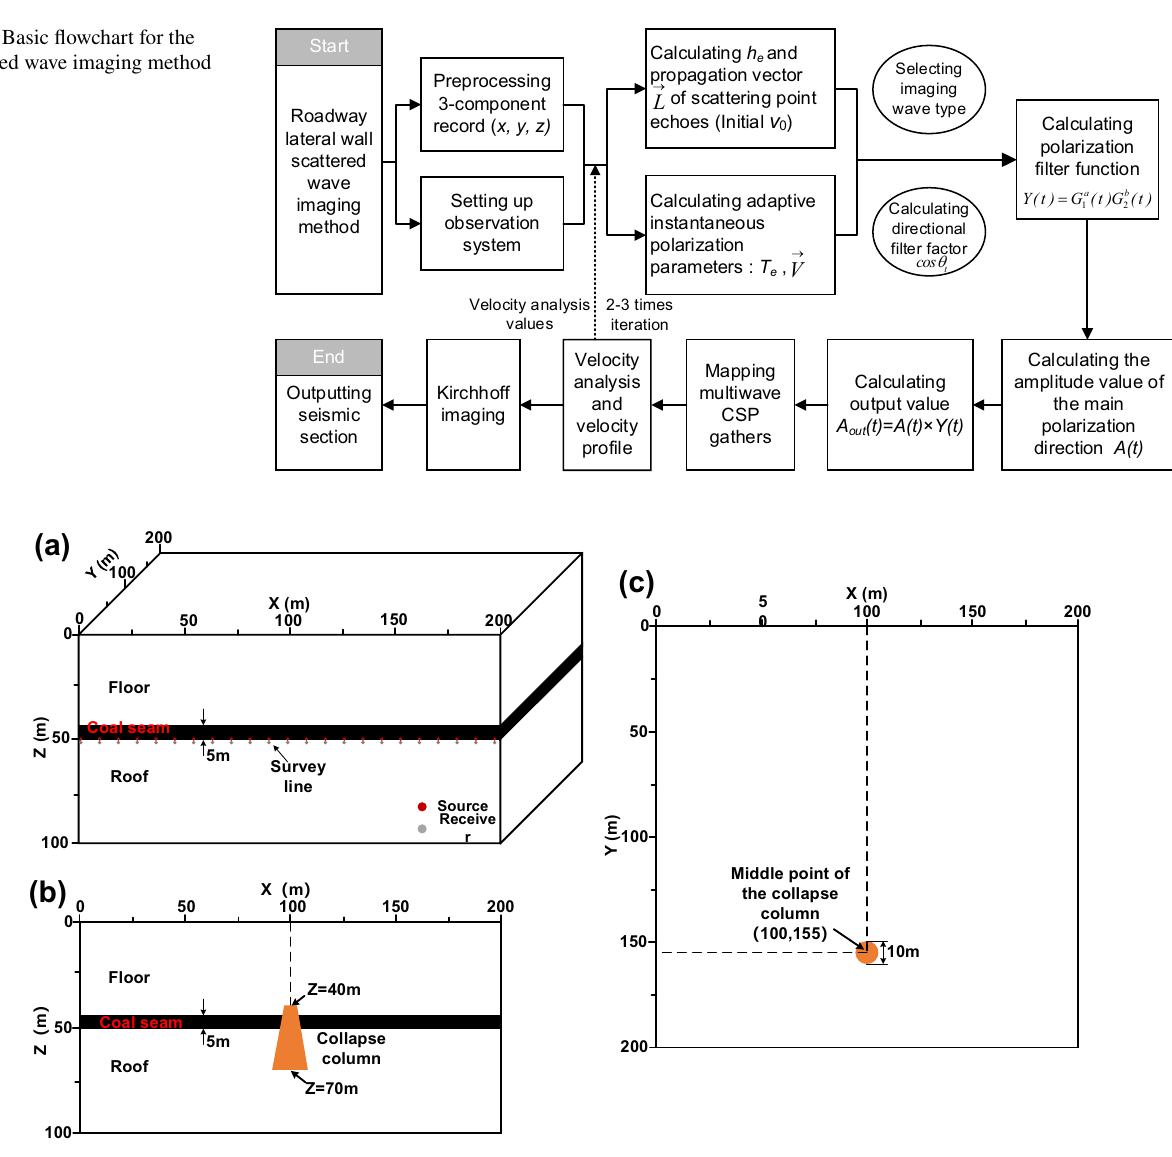
Fig. 4 Three-dimensional (3D) coal working face with a collapsed column: a 3D model diagram, b XZ sectional view, c XY sectional view